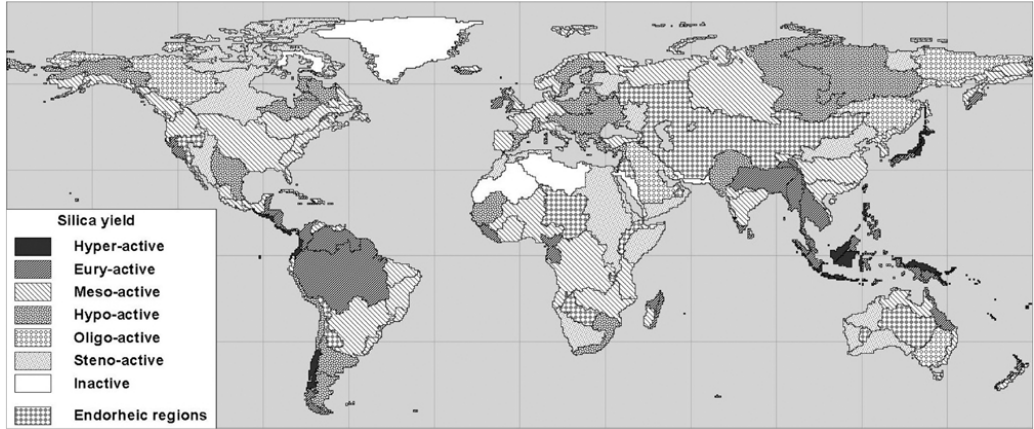
Fig. 4. Relative natural dissolved silica yield for coastal catchments (COSCATs) (115Mkm 2 , n ≈ 140, global mean yield 3.3tDSikm − 2 yr − 1 ) . Inactive areas 0–0.01 × global mean yield, steno-active 0.01–0.1x, oligo-active 0.1–0.2x, hypo-active 0.2–0.5x, meso- active 0.5–2x, eury-active 2–5x, hyper-active 5–10x. No Hot spots ( > 10 × global mean yield) are observed at this scale. Silica yield classes